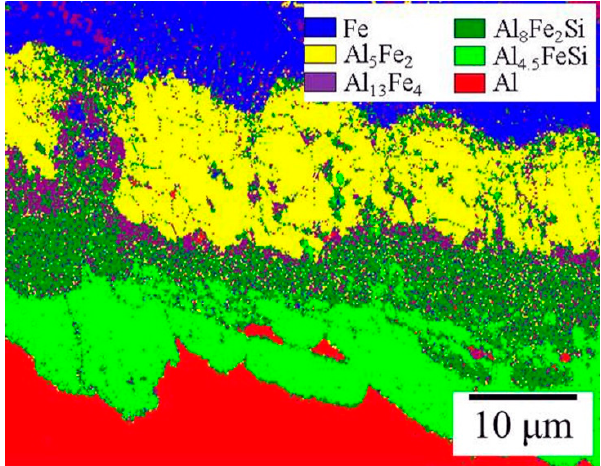
Figure 8. EBSD phase distribution maps of compounds formed at the cast iron/liquid Al–Si alloy interface isothermally heated at 720 °C: ( a ) for 1 min, ( b ) 5 min.